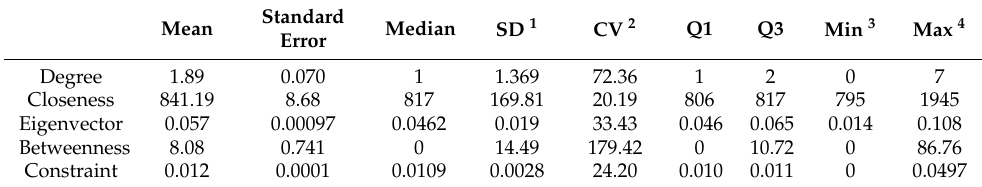
Table 2. Centrality network measures in dual-purpose farms.